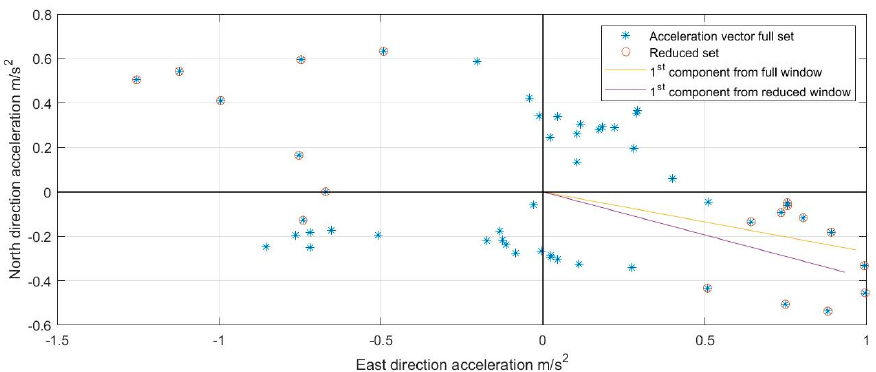
Figure 15. Principal Component Analysis (PCA) for full step window vs. reduced step window. The heading derived from the PCA is computed based on the components of the unity vector representing the correlation of the data as shown in Equation (5) but is also